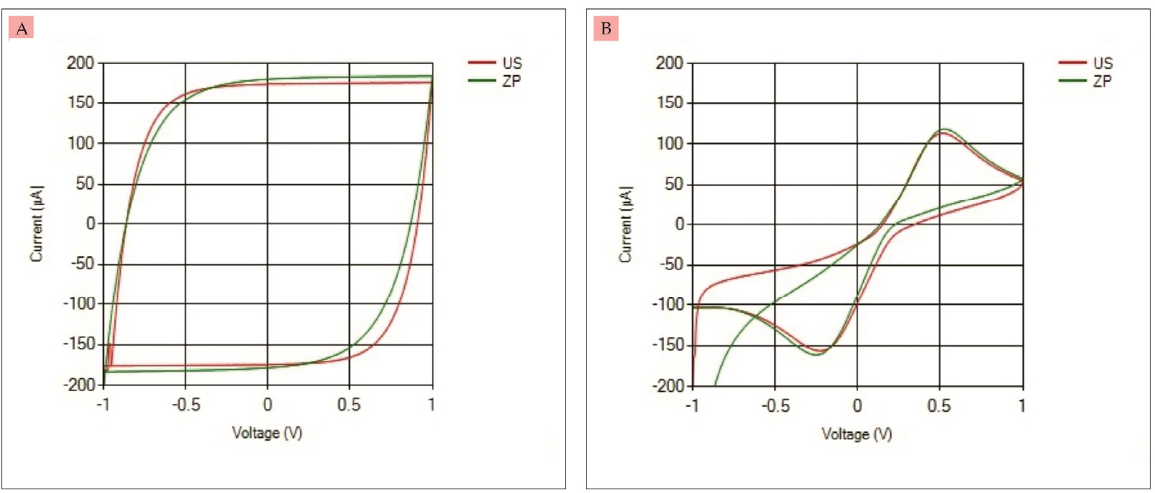
Figure 9. ( A ) CV measurement on dummy circuit using UnpadStat and commercial potentiostat, ( B ) CV measurement on commercial SPCE using UnpadStat and commercial potentiostat. Table 3. Comparison of CV measurement results.